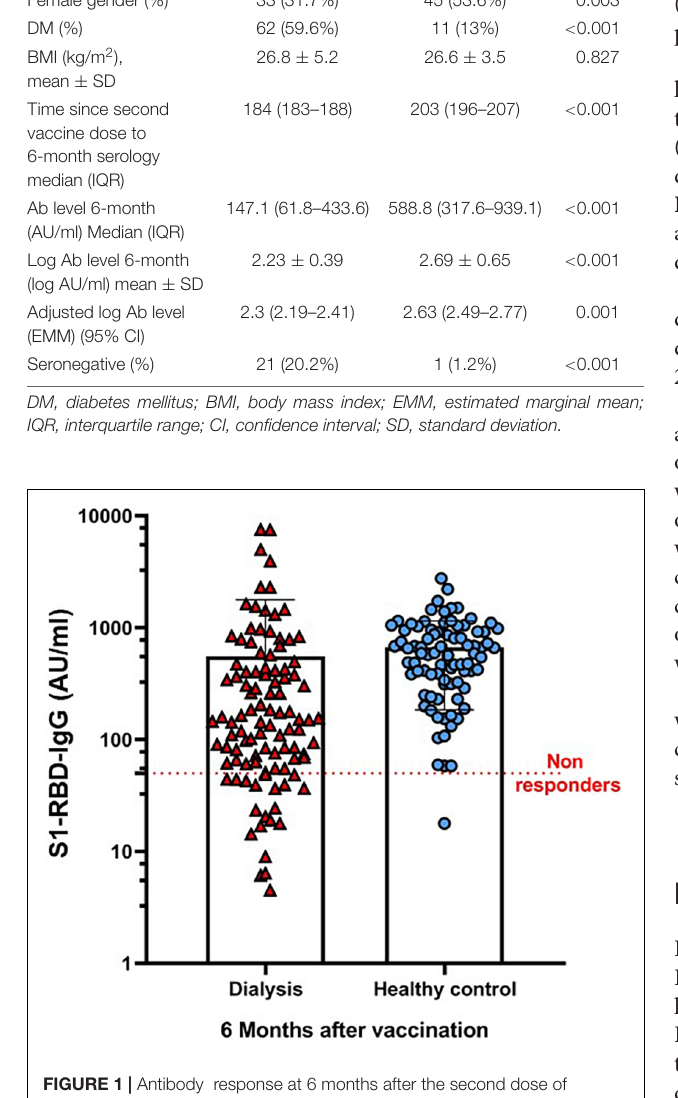
FIGURE 1 | Antibody response at 6 months after the second dose of BNT162b2 vaccine for HD Patients and the healthy control group. Results refer to the HD group ( n = 104) and the control group ( n =